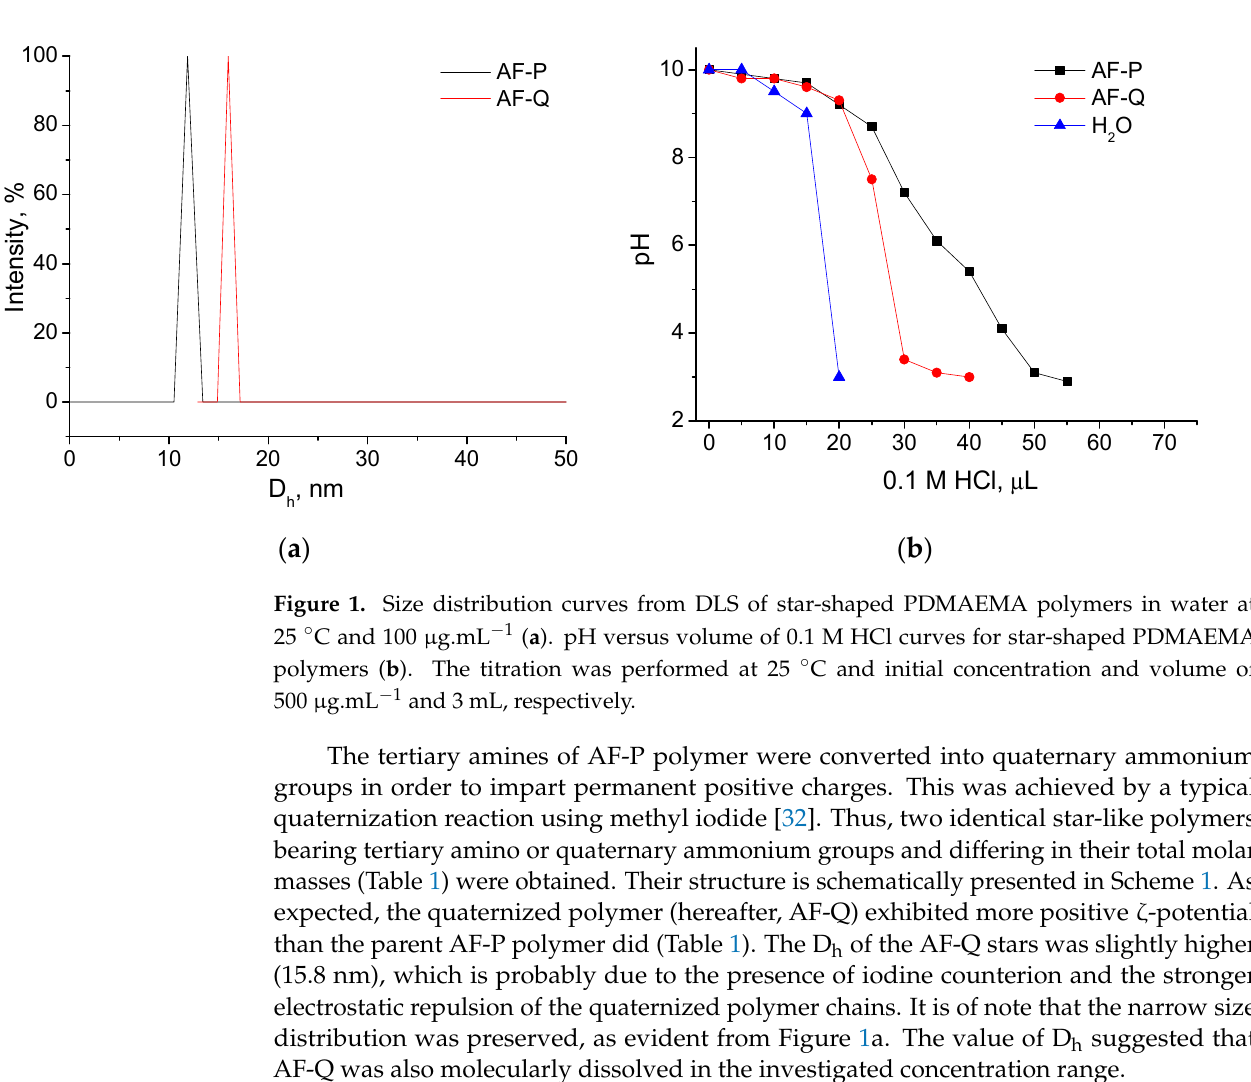
Scheme 1. Schematic presentation of the structure of the PDMAEMA-based star-like polymers.